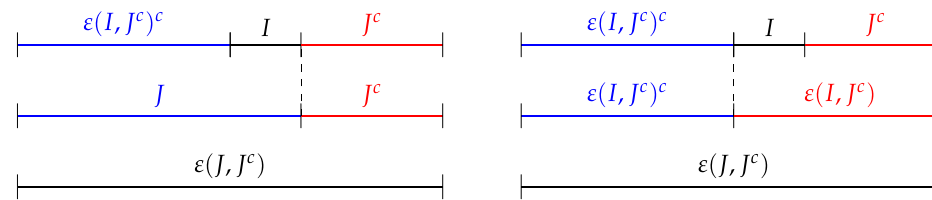
Figure A2. Visual aid for the permutations in Equation